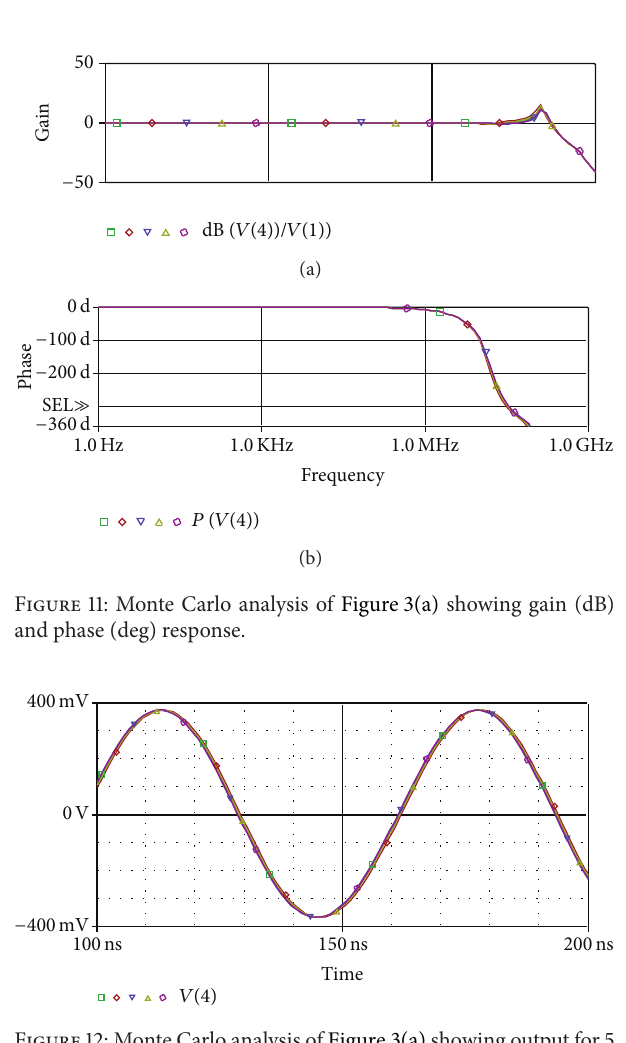
Figure 12: Monte Carlo analysis of Figure 3(a) showing output for 5